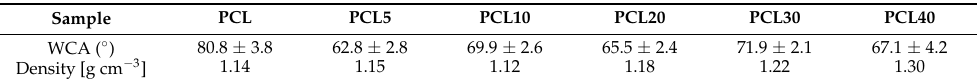
Table 1. Water contact angles and densities for PCL composites with glass beads.